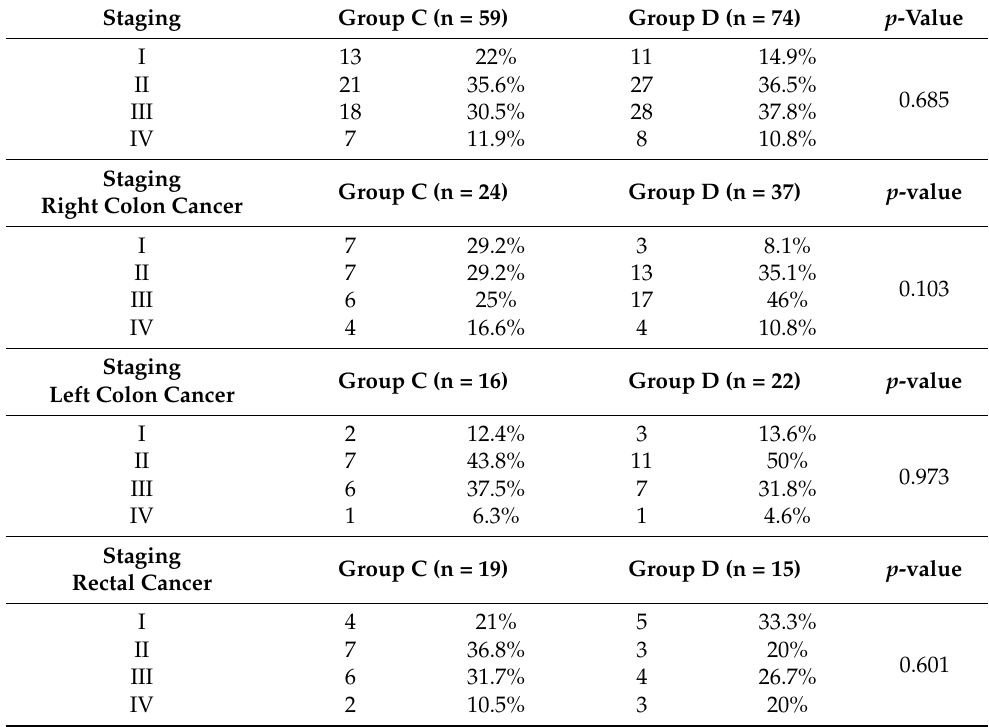
Table 3. Primary outcomes for pandemic subset of analysis.